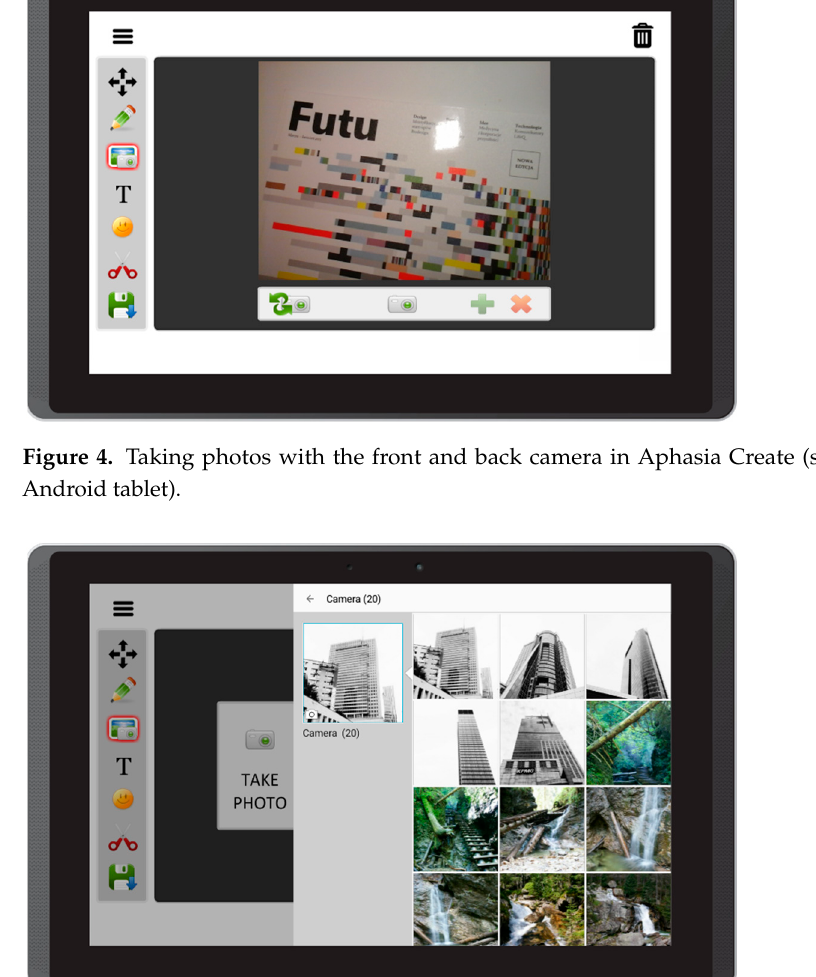
Figure 5. Accessing camera memory for loading and saving images in Aphasia Create (screenshot from an Android tablet).